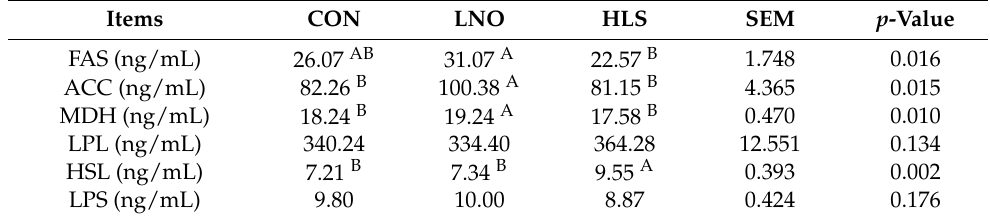
Table 5. The effect of dietary flaxseed oil or flaxseed supplementation on the enzymes related to lipid metabolism in blood of Albas cashmere